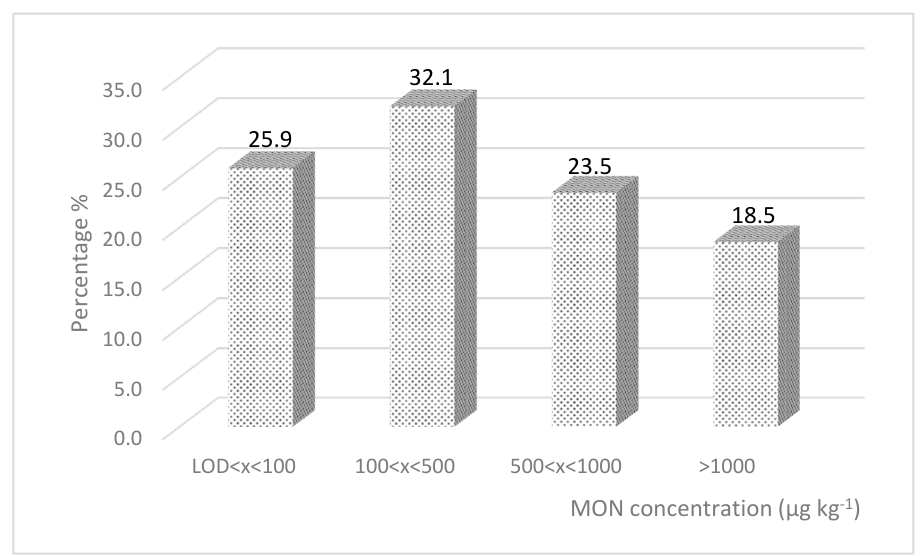
Figure 2. MON relative frequency distribution in maize samples collected in Northern Italy in 2018.